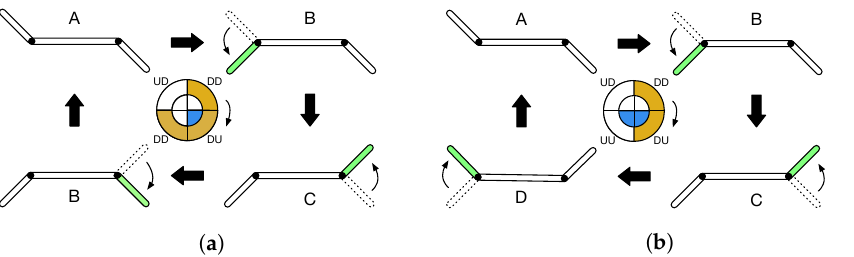
Figure 1. Types of movement of a Purcell’s three-link swimmer: ( a ) reciprocal ( b )